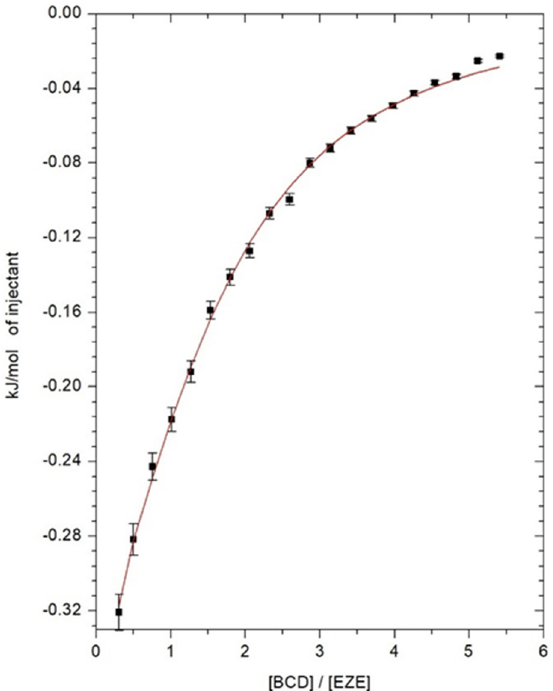
Figure 3. Direct effects of interaction between 0.5 mM ezetimibe and 14.2 mM β -cyclodextrin.